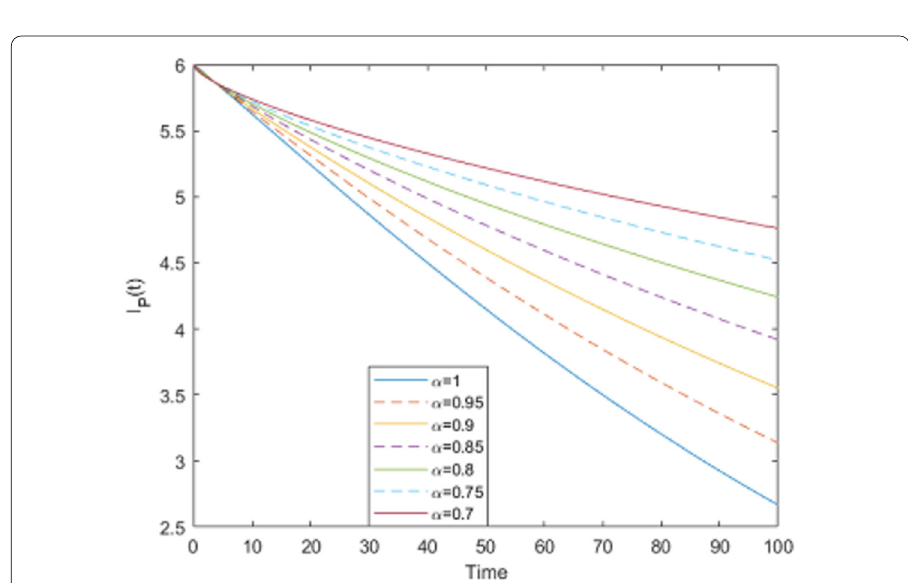
Figure 10 The class of researchers affected but still with positive